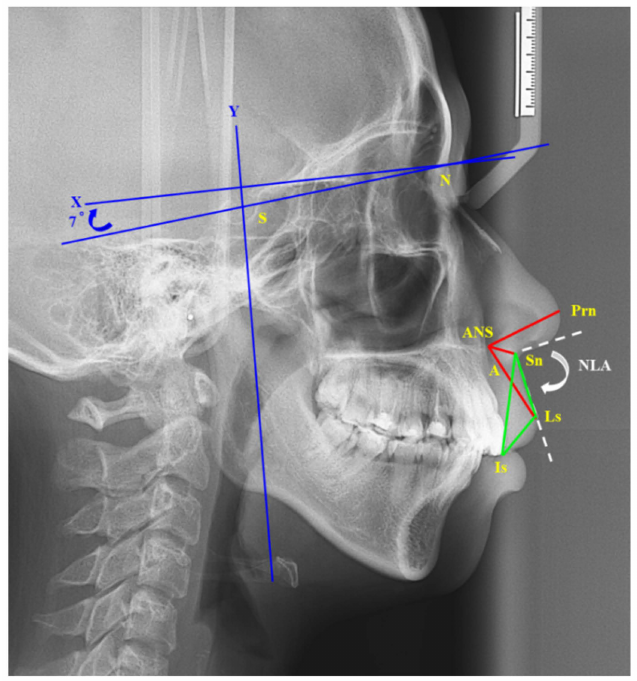
Figure 4. Cephalometric landmarks: sella (S), nasion (N), point A, pronasale (tip of nose, Prn), subnasale (Sn), labrale superius (Ls), anterior nasal spine (ANS), and incisor superius (Is). The X-axis (horizontal line) was constructed by drawing a line through N and 7 ◦ above the NS line, and the Y-axis (vertical line) passed through S and was perpendicular to the X-axis. The following distances and angles were measured: red line: ANS–Prn, ANS–Sn, ANS–Ls; green line: Is–Sn, Is–Ls, Ls-Sn; white dotted line: nasolabial (NLA) angle.